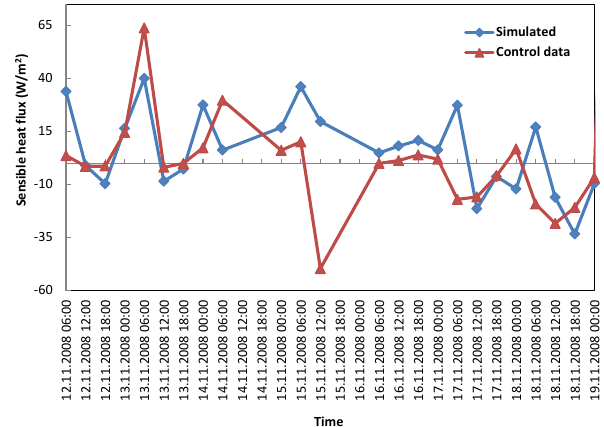
Fig. 5 Comparison of best model performance (simulation 5) with control data, for six-hourly 2 Figure 5. Comparison of best model performance (simulation 5) with control data, for 6-hourly SHF prediction during typhoon